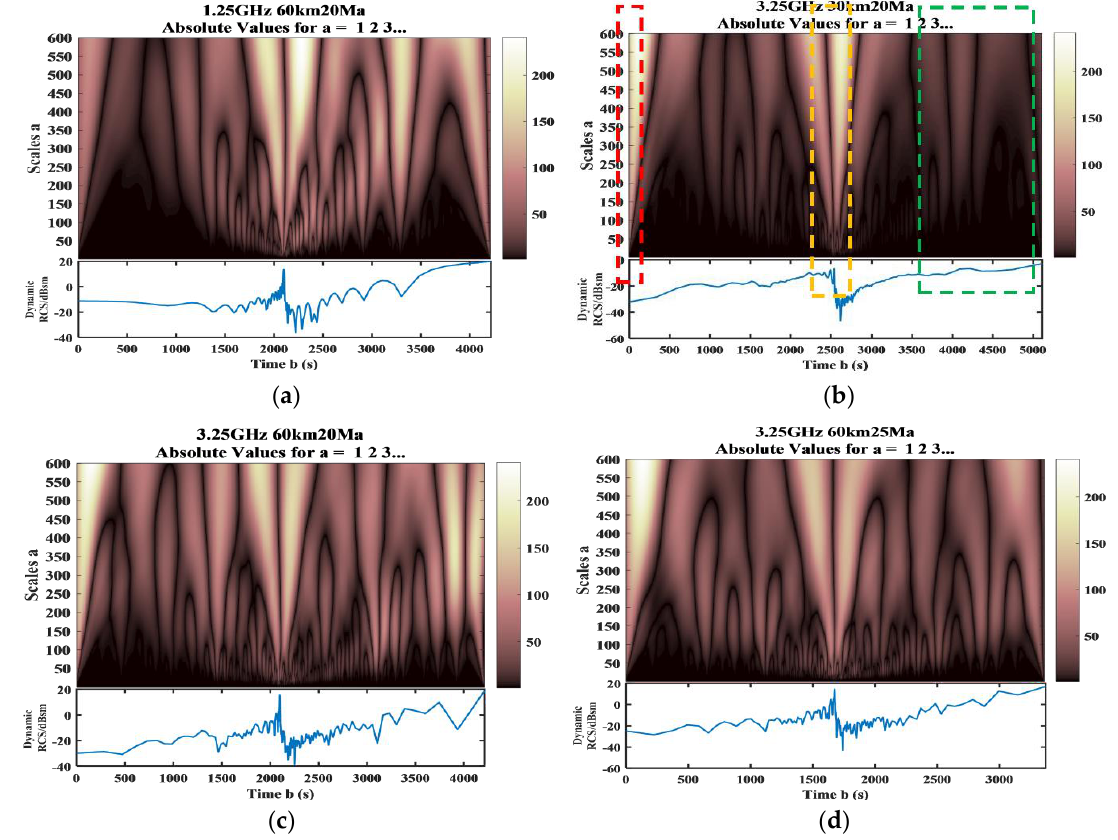
Figure 8. Time-scale diagram of dynamic RCS time series of a hypersonic vehicle covered with a plasma sheath after continuous wavelet transform at a velocity and height above the ground of: ( a ) 20 Mach and 60 km, respectively (incident wave frequency is 1.25 GHz); ( b ) 20 Mach and 30 km, respectively (incident wave frequency is 3.25 GHz); ( c ) 20 Mach and 60 km, respectively (incident wave frequency is 3.25 GHz); and ( d ) 25 Mach and 60 km, respectively (incident wave frequency is 3.25 GHz).